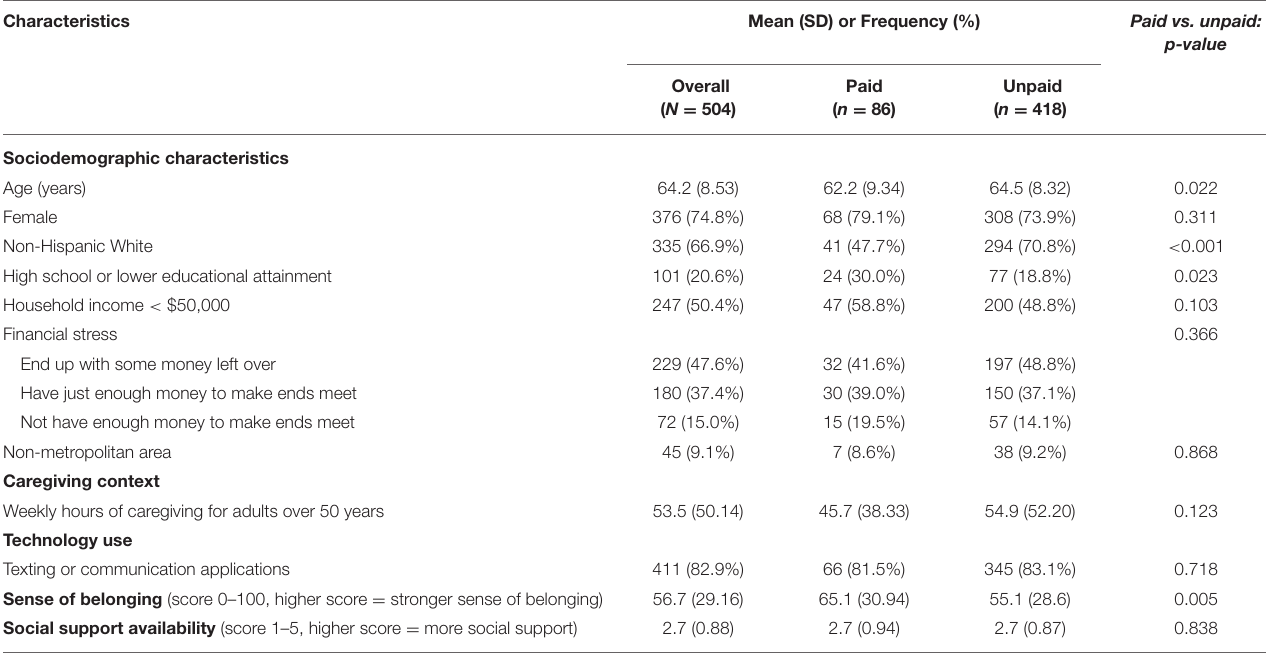
TABLE 1 | Study participants’ sociodemographic characteristics, technology use, sense of belonging to their local community and social bonds, by caregiver payment status (paid/unpaid). Characteristics